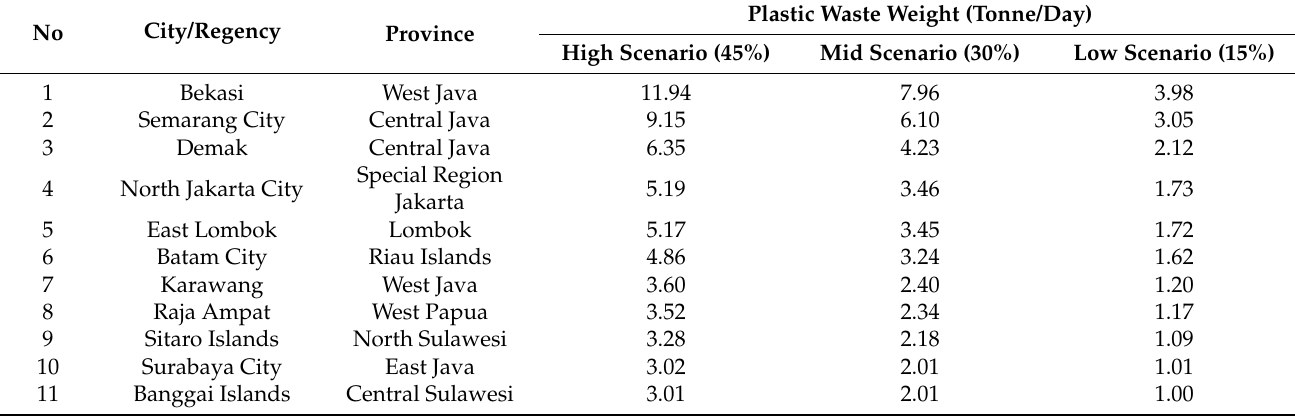
Table 3. Quantitative results of the accumulated amount of plastic waste for each regency/city from three